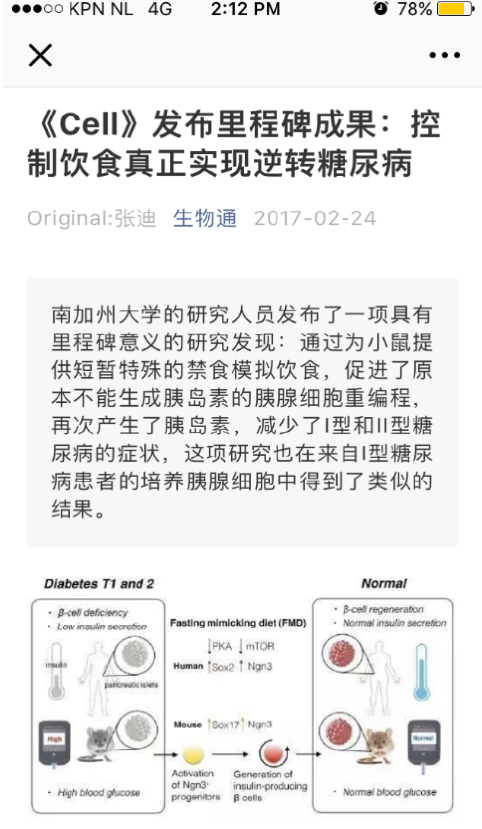
Figure 1. The first page of a WeChat article in our